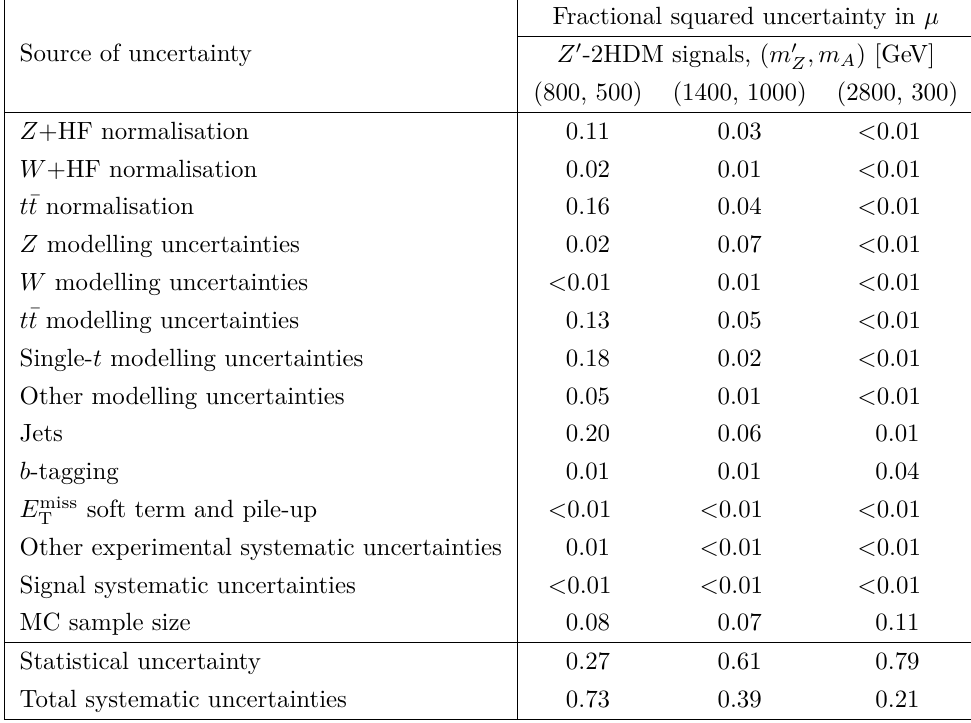
Table 3. Relative importance of the different sources of uncertainty for different Z 0 -2HDMs, with the masses of the Z 0 boson and the A boson given in the second row, expressed as fractional impact on the signal strength parameter. The fractional impact is calculated by considering the square of the uncertainty in the signal strength parameter arising from a given group of uncertainties (as listed in the left column of the table), divided by the square of the total uncertainty in the signal strength parameter. Due to correlations, the sum of the different impacts of systematic uncertainties might not add up to the total impact of all systematic